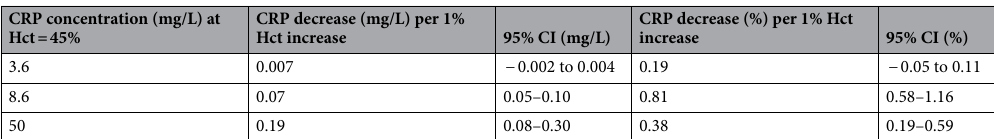
Table 3. Effect of hematocrit on CRP. From the data in Fig. 3, a simple linear regression analysis provided the slope and 95% confidence interval (CI), Hct = hematocrit.